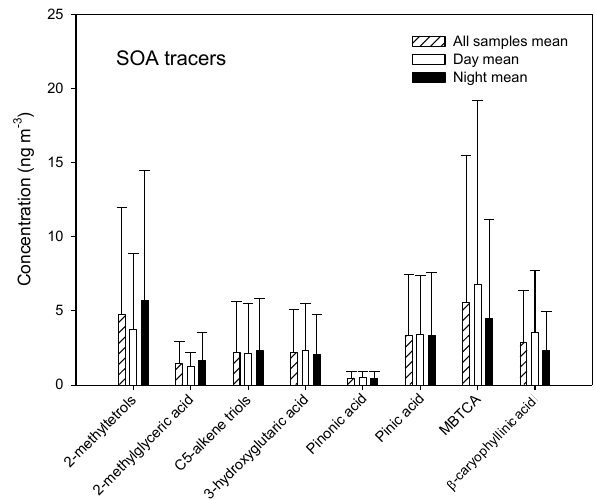
Figure 5. Average concentrations of SOA tracers detected in marine aerosols over the East China